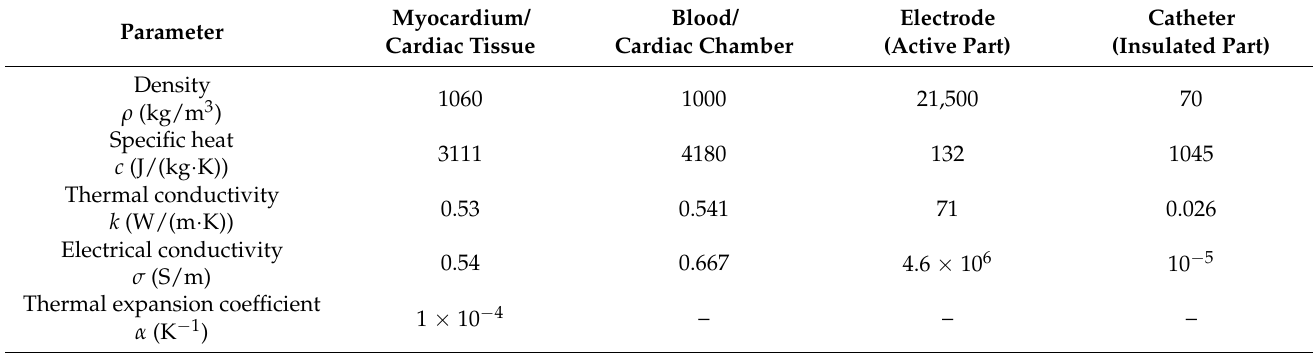
Table 1. Material properties considered in the present study for different